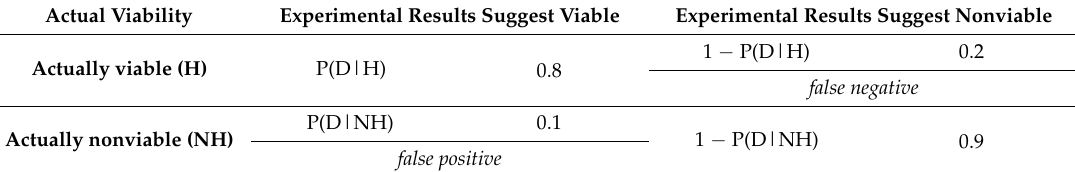
Table 2. An example of a table of experimental reliability that enters a Bayesian analysis to assess the revised probability of economic operations. Some assumed values have been inserted to give an example. Actual Viability Experimental Results Suggest Viable Experimental Results Suggest Nonviable Actually viable (H) P(D|H) Actually nonviable